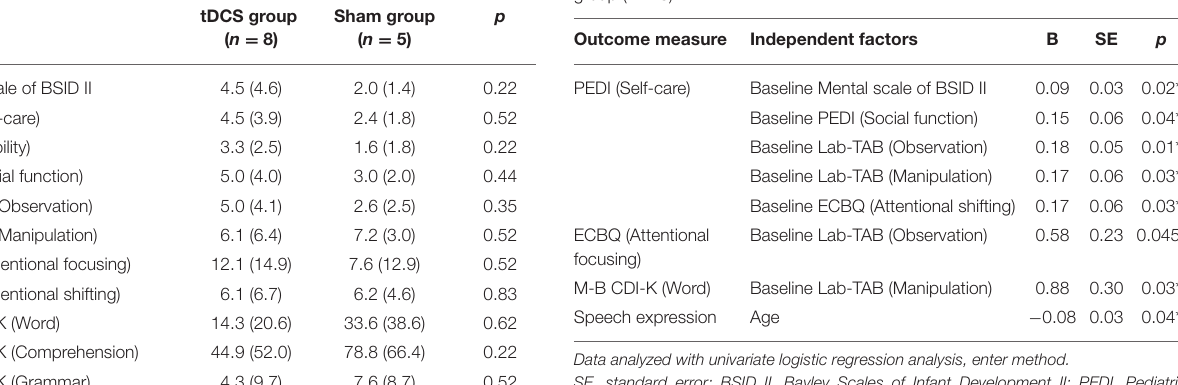
TABLE 3 | Comparisons of improvements in outcomes between the two groups. TABLE 4 | Independent factors associated with improved outcomes in the tDCS group ( n =